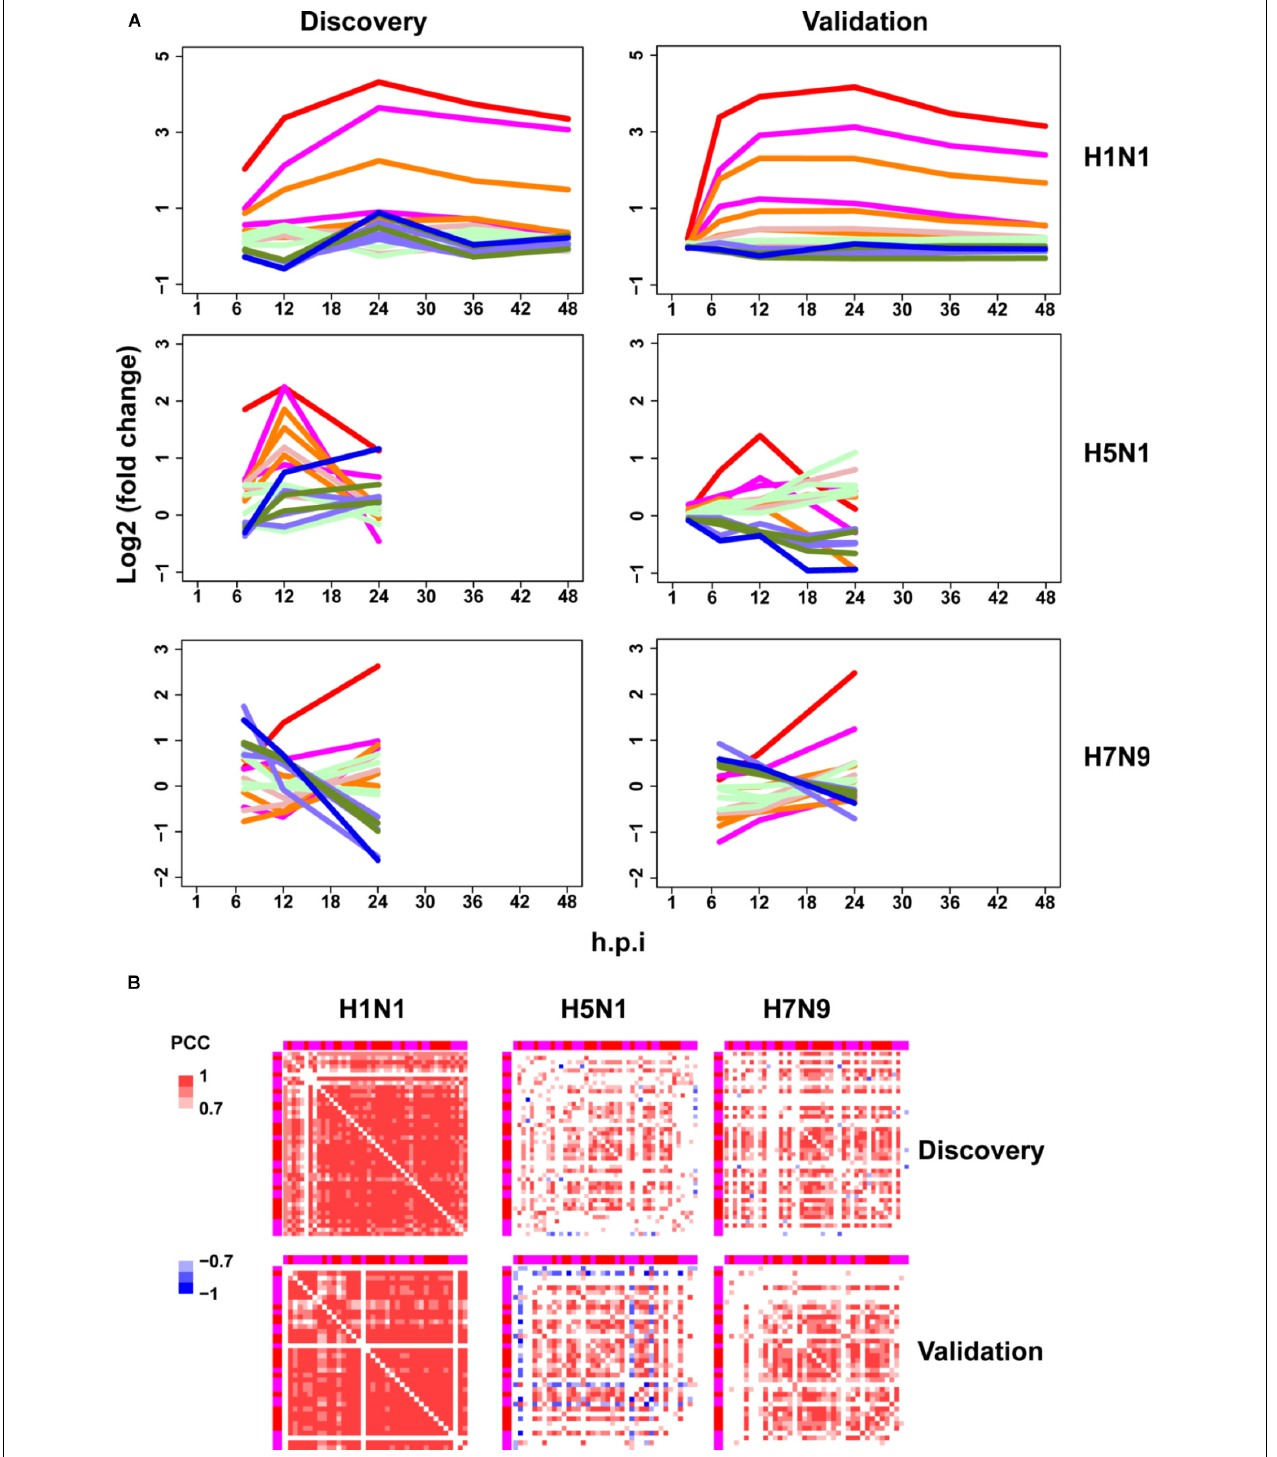
FIGURE 3 | Perturbation of ASGs upon wild-type IAV infection. (A) Expression trends of the 1819 ASGs during infection of human and avian IAV. These lines have the same meanings as those of Figure 2D . For the same IAV strain, the discovery and validation datasets are from infection at the same MOI. (B) Expression correlations between the 44 early upregulated ASGs. The top and left annotation colors for different gene groups have the same meanings as those of lines in Figure 2D . In order to highlight strong correlations, highly positive correlations with PCCs ≥ 0.7 are set as red color, highly negative correlations with PCCs ≤ –0.7 for blue color, and weak correlations with PCCs > –0.7 and PCCs < 0.7 for white color.